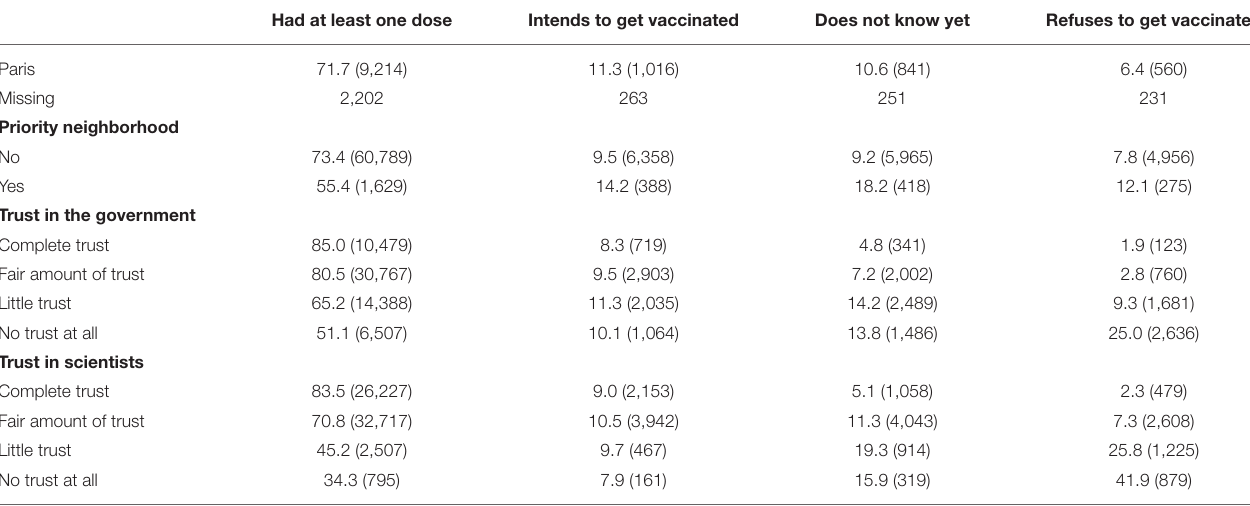
Frontiers in Public Health |